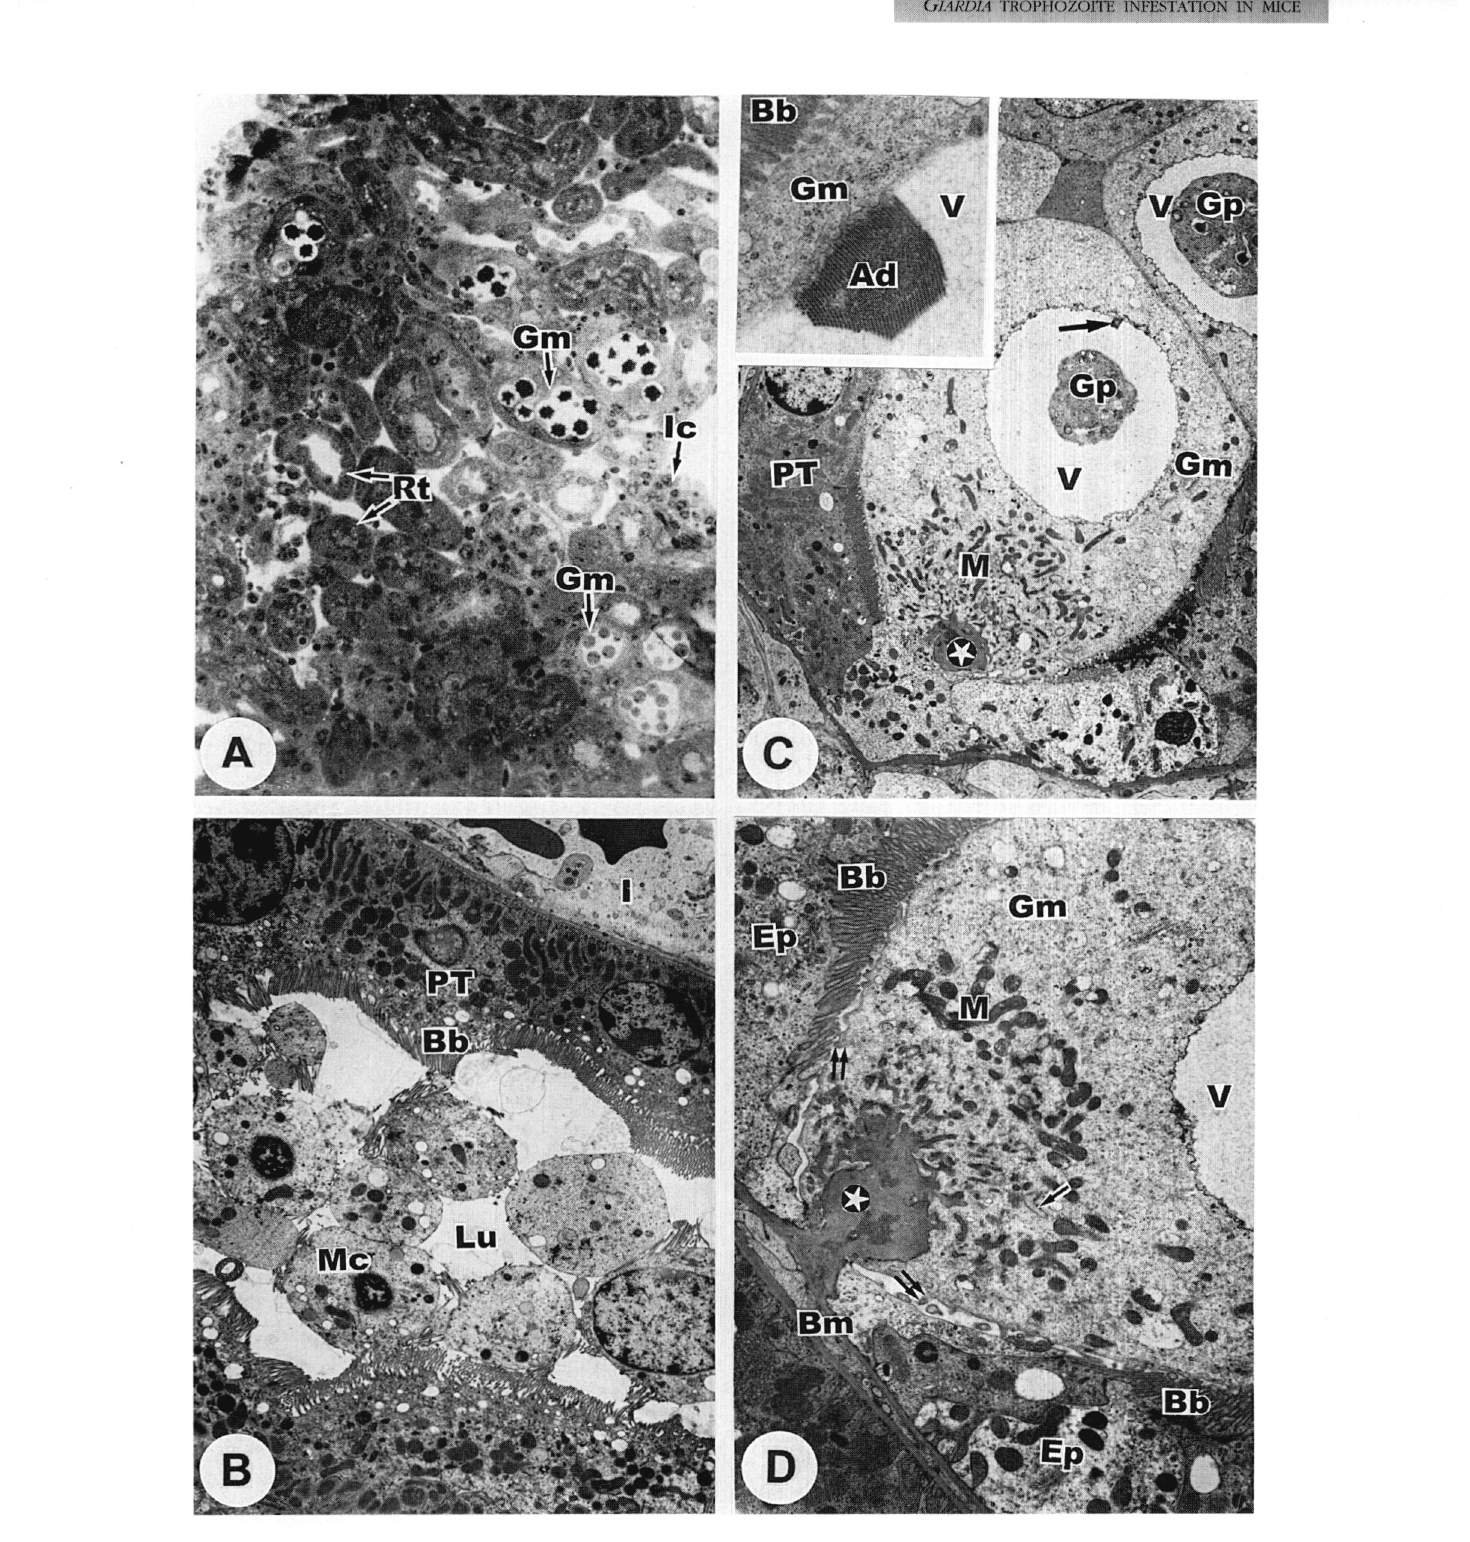
Fig. 3. - A : Light micrograph of semithin section of renal tubules (Rt) showing many inflammatory cells (Ic), and giant macrophages (Gm), containing many autophagic vacuoles, x 500. - B: TEM of the lumen of renal tubule (Lu) showing many macrophages (Mc). Proximal tubule (PT). Interstitium (I). Brush border (Bb). x 3,100. - C : TEM of one giant macrophage (Gm), in a proximal renal tubule (PT) demons­ trating large autophagic vacuole (V), with Giardia particulate (Gp), and many mitochondrial bodies (M). Arrow points to adhesive disc of Giardia trophozoite. Brush border (Bb). Star points to irregular part of proximal tubular membrane and start of fixation of macrophage, x 5,500. Insert: shows a magnification of the autophagic vacuole (V), with a part of Giardia adhesive disc (Ad), x 20,000. — D : Higher magnification of giant macrophage (Gm) showing a branched part (star) of the tubular basement membrane (Bm). Many mitochondria (M), with few endoplasmic reticulum cisternae (single arrow). Note surface projections of macrophage (double arrows). Epithelial cell (Ep). Brush border (Bb). Autophagic vacuole (V). x